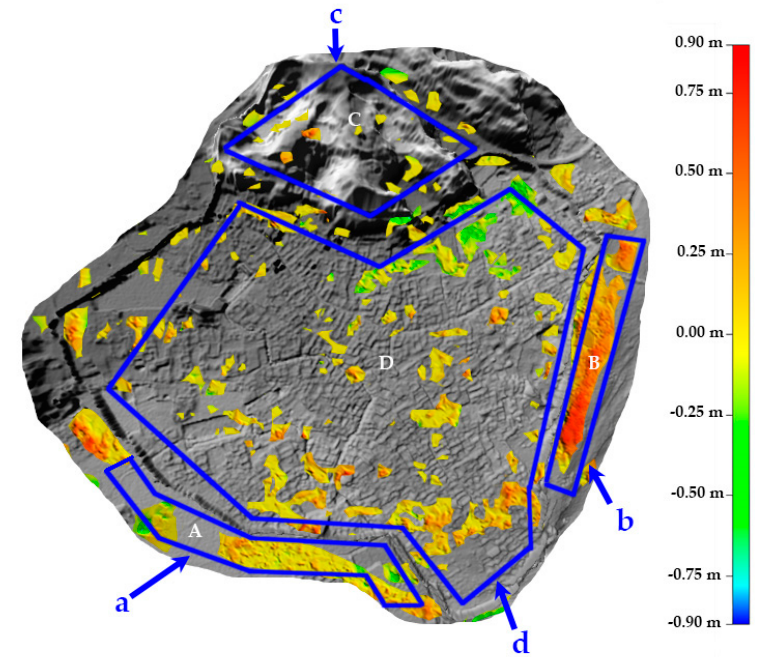
Figure 8. Spatial distribution of topographical changes in the ancient town.